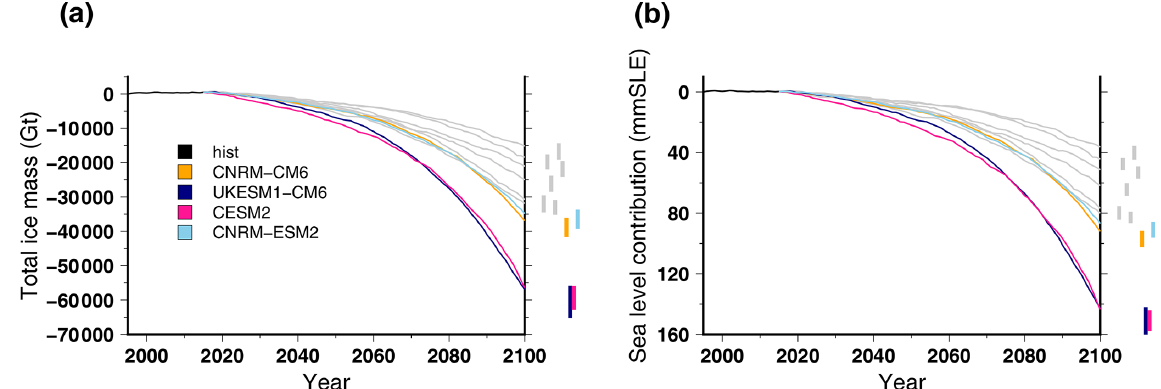
Figure 6. Simulated total ice mass change for the historical experiment hist (1995–2015) and the projections under the different CMIP6 forcings using the SSP585 scenario and the medium oceanic sensitivity: (a) total mass change and (b) ice volume contributing to sea level rise. For each projection experiment, the right-hand-side vertical bar shows the minimal and maximal changes associated with the oceanic- forcing uncertainty ( low and high scenarios). The grey lines are the changes under the CMIP5 forcings shown in Fig. 4.